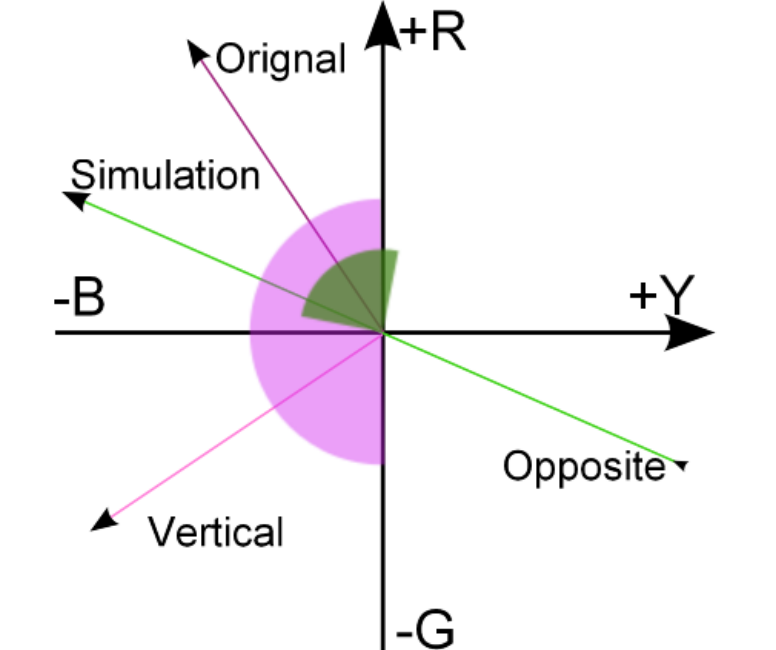
Figure 8. An illustration of the color warping range from the green area to the red